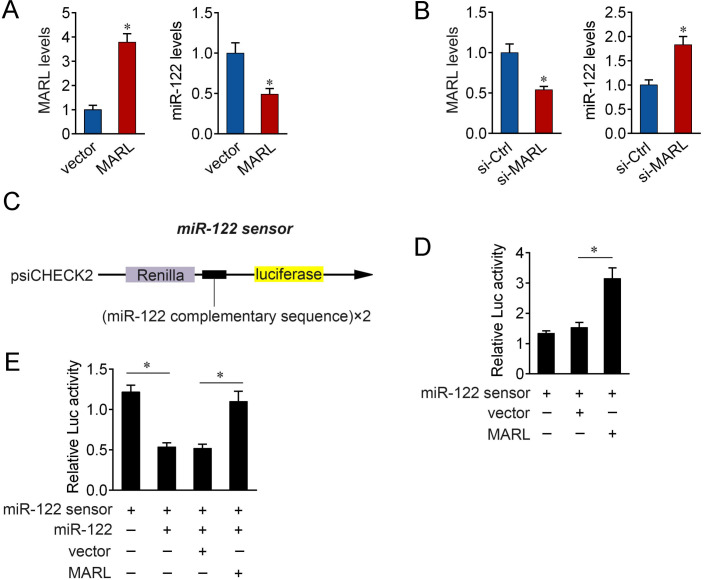
MARL regulates miR-122 expression and activity.(A) Overexpression of MARL reduces the expression of miR-122. Transfection of pcDNA3.1 vector or MARL expression plasmid into MIC cells for 48 h. The expression of MARL and miR-122 were measured by qPCR, respectively. (B) Knockdown of MARL upregulated miR-122 expression. MIC cells were transfected with MARL-specific siRNAs (si-MARL) or si-Ctrl for 48 h. The expression of MARL and miR-122 were measured by qPCR, respectively. (C) miR-122 sensor construct. The miR-122 sensor was constructed by inserting two copies of perfectly matched miR-122 fragments into psiCHECK-2 vector. (D) MARL overexpression induced the luciferase activity. MIC cells were transfected with pcDNA3.1 vector or MARL expression plasmid, together with miR-122 sensor. At 48 h post-transfection, the luciferase activity was analyzed. (E) MARL reduces miR-122 activity. MIC cells were transfected with miR-122, pcDNA3.1 vector, or MARL expression plasmid, together with miR-122 sensor for 48 h. The luciferase activity was analyzed and normalized to renilla luciferase activity. All data represented the mean ± SE from three independent triplicated experiments. *, p < 0.05.